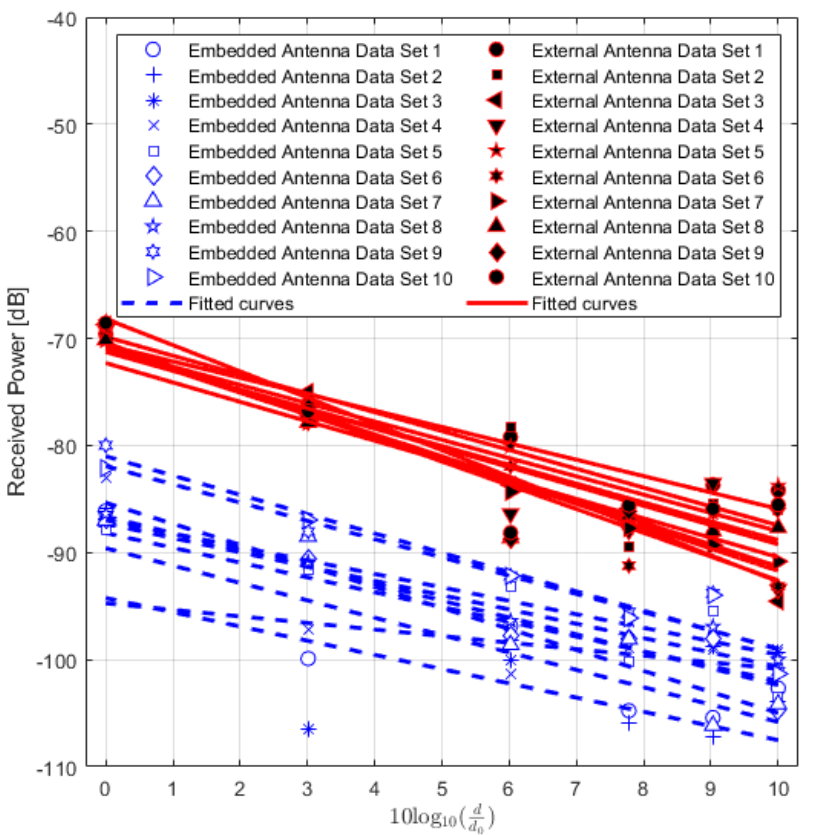
Figure 14. IQRF received power variation comparison for both transceivers with embedded and external